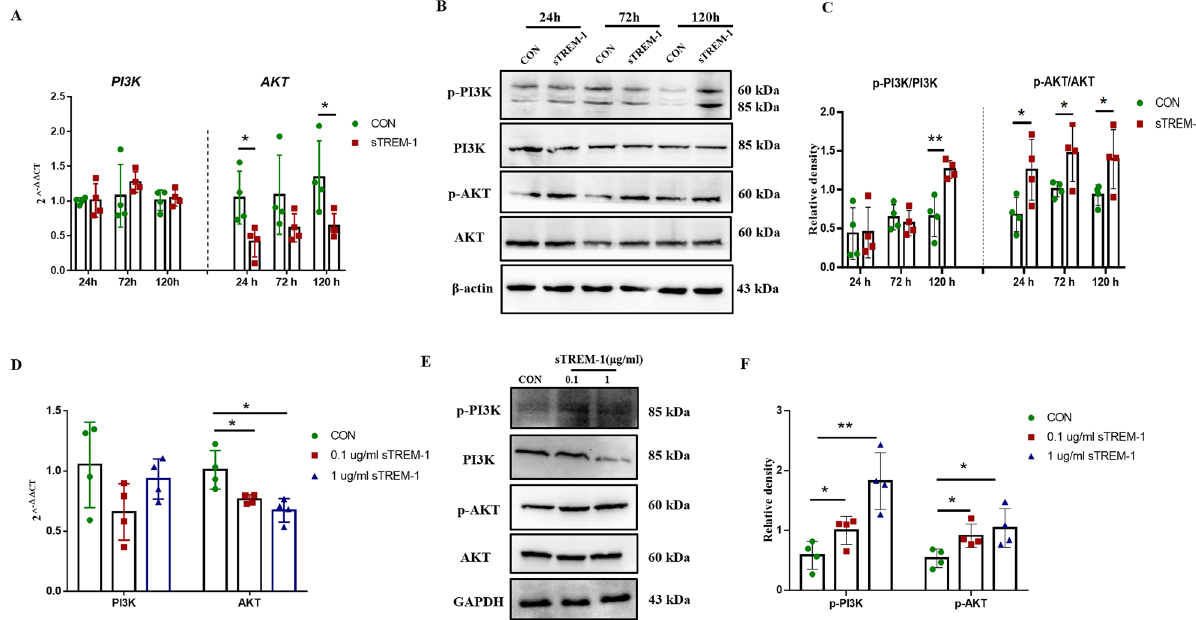
Figure 6. sTREM-1 activates the PI3K-AKT pathway in vivo and in vitro. (A) The mRNA expression levels of PI3K and AKT in mouse hippocampus detected by Q-PCR, n = 4. (B) Representative western blot images of p-PI3K, PI3K, p-AKT and AKT protein expression in mouse hippocampus. (C) Quantitative analysis of p-PI3K/ PI3K and p-AKT/AKT protein level in mouse hippocampus, n = 4. (D) The mRNA expression levels of PI3K and AKT in different BV2 cells groups by Q-PCR, n = 4. (E) Representative western blot images of p-PI3K, PI3K, p-AKT, and AKT protein expression in different BV2 cell groups. (F) Quantitative analysis of p-PI3K/PI3K and p-AKT/AKT protein level in different BV2 cell groups, n = 4. Data are presented as means ± SEM of at least three separate experiments. * P < 0.05, ** P <